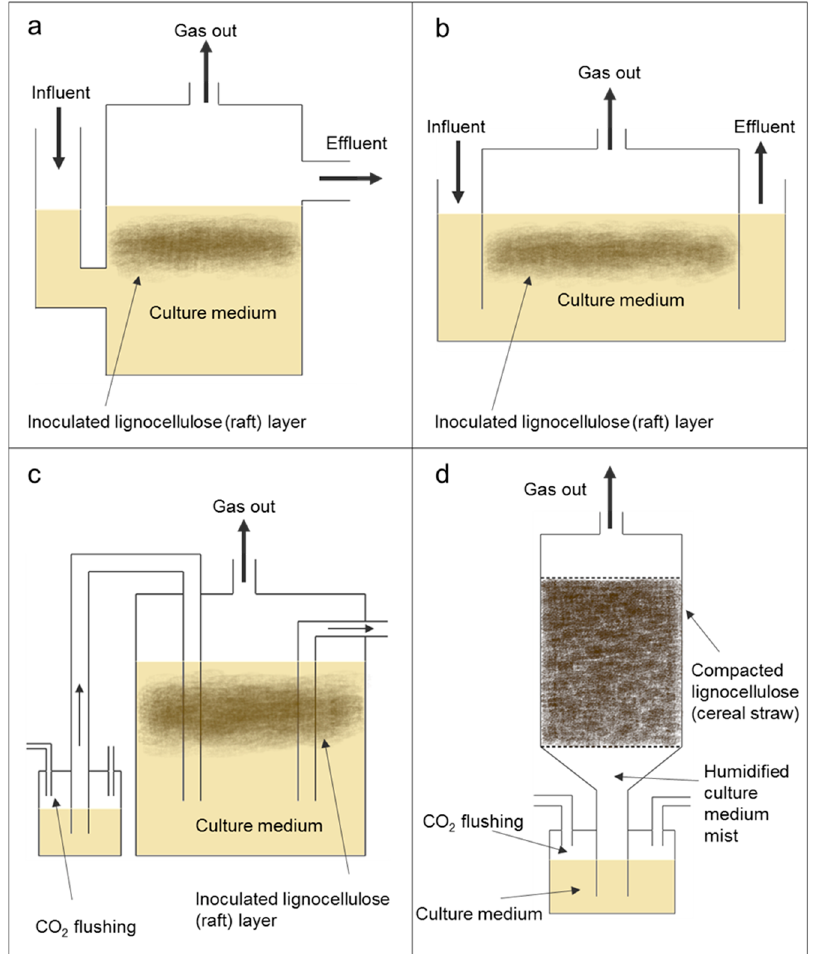
Figure 2. Schematic bioreactor and anaerobic digester designs for industrial-scale use of anaerobic fungi. A lignocellulose (raft) layer forms due to biomass floating as anaerobic fungi ferment their substrate: ( a ) up-flow anaerobic digester where anaerobic fungi are grown ± methanogens to produce CH 4 , H 2 and CO 2 ; ( b ) plug flow anaerobic digester; ( c ) continuous-flow bioreactor